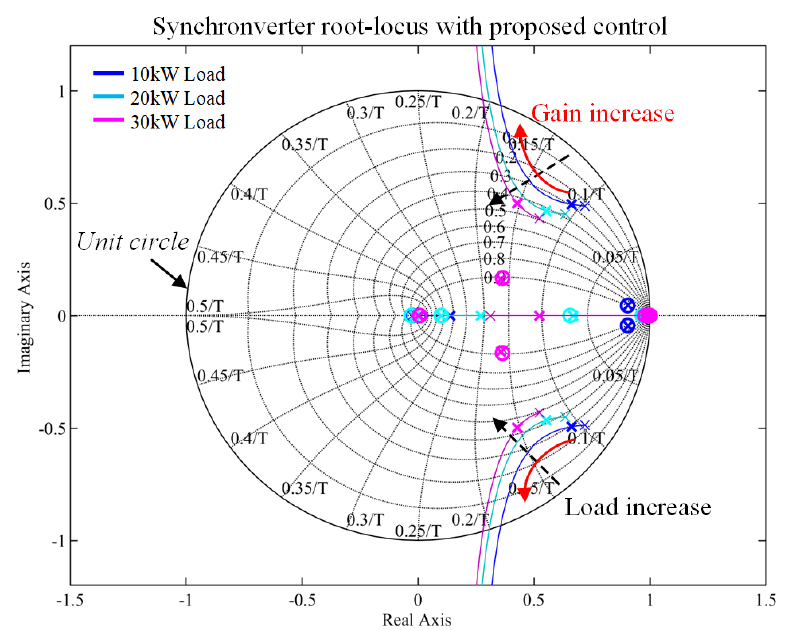
Figure 7. Root − locus of proposed control